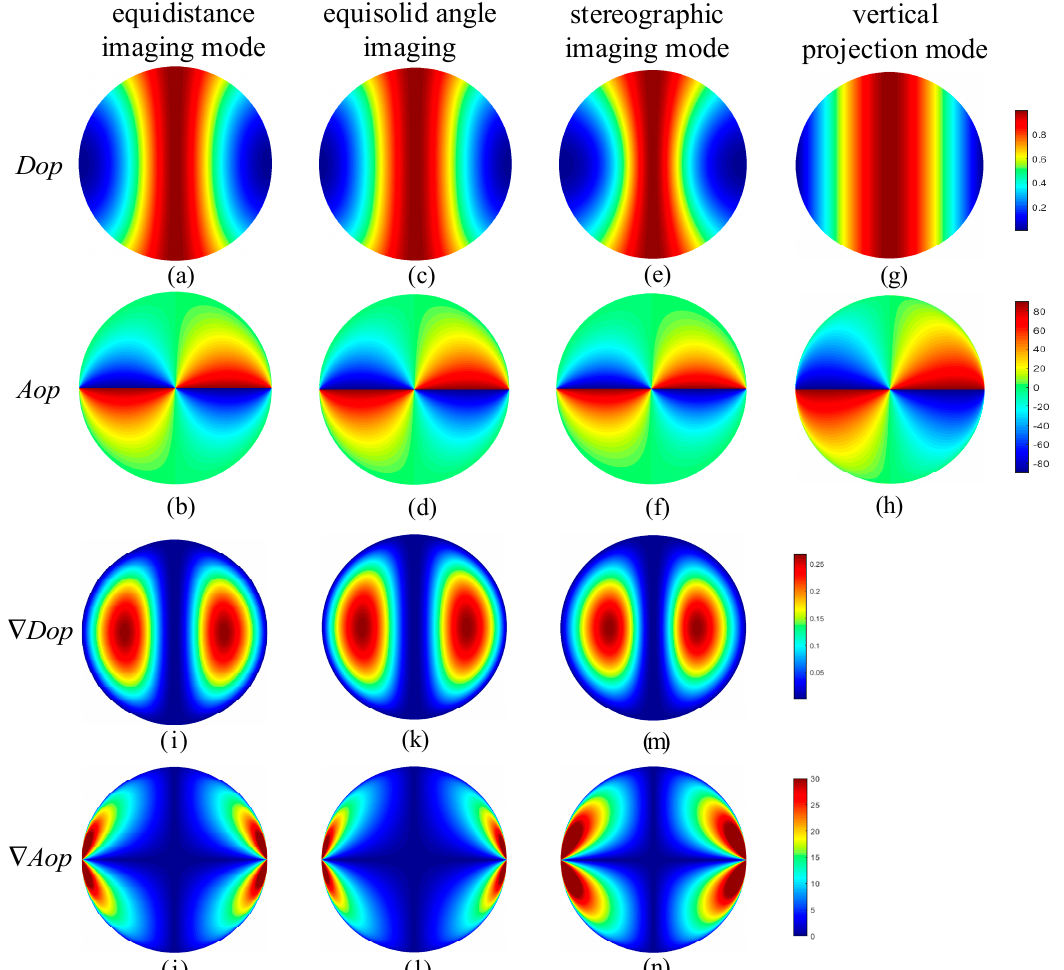
Figure 7. The improved models of skylight polarization in three imaging modes when the elevation angle is 0 ◦ and the azimuth angle is 90 ◦ ; ( a ) Dop in equidistance imaging mode; ( b ) Aop in equidistance imaging mode; ( c ) Dop in equisolid angle imaging mode; ( d ) Aop in equisolid angle imaging mode; ( e ) Dop in stereographic imaging mode; ( f ) Aop in stereographic imaging mode; ( g ) Dop in vertical projection mode (without fisheye lens); ( h ) Aop in vertical projection mode (without fisheye lens); ( i , j ) the di ff erence in skylight polarization pattern between the equidistance imaging mode and the vertical projection mode; ( k , l ) the di ff erence in skylight polarization pattern between the equisolid angle imaging mode and the vertical projection mode;.( m , n ) the di ff erence in skylight polarization pattern between the stereographic imaging mode and the vertical projection